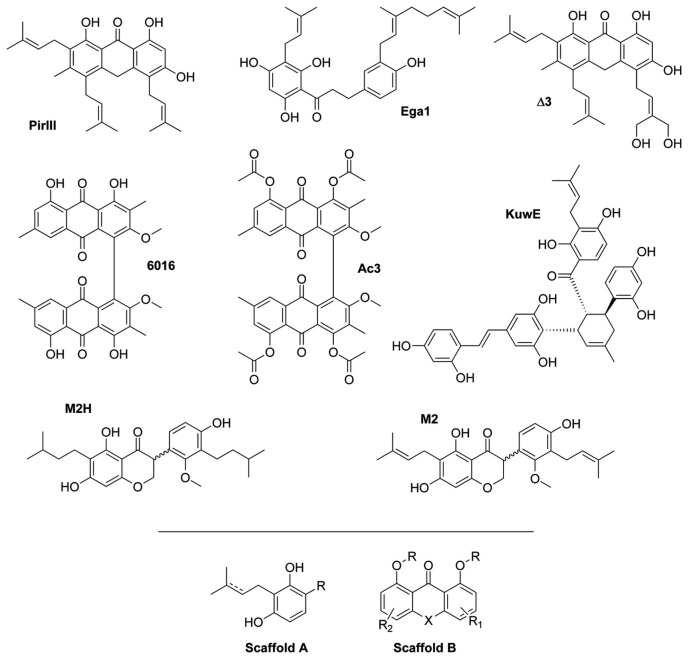
Structures of PtpB inhibitors.Chemical structure of PtpB inhibitors showing an IC50 < 100 µM. Below the line are the two common chemical scaffolds: Scaffold A present in KuwE, Ega1, M2 and M2H; Scaffold B present in PirIII, Δ3, 6016 and Ac3.